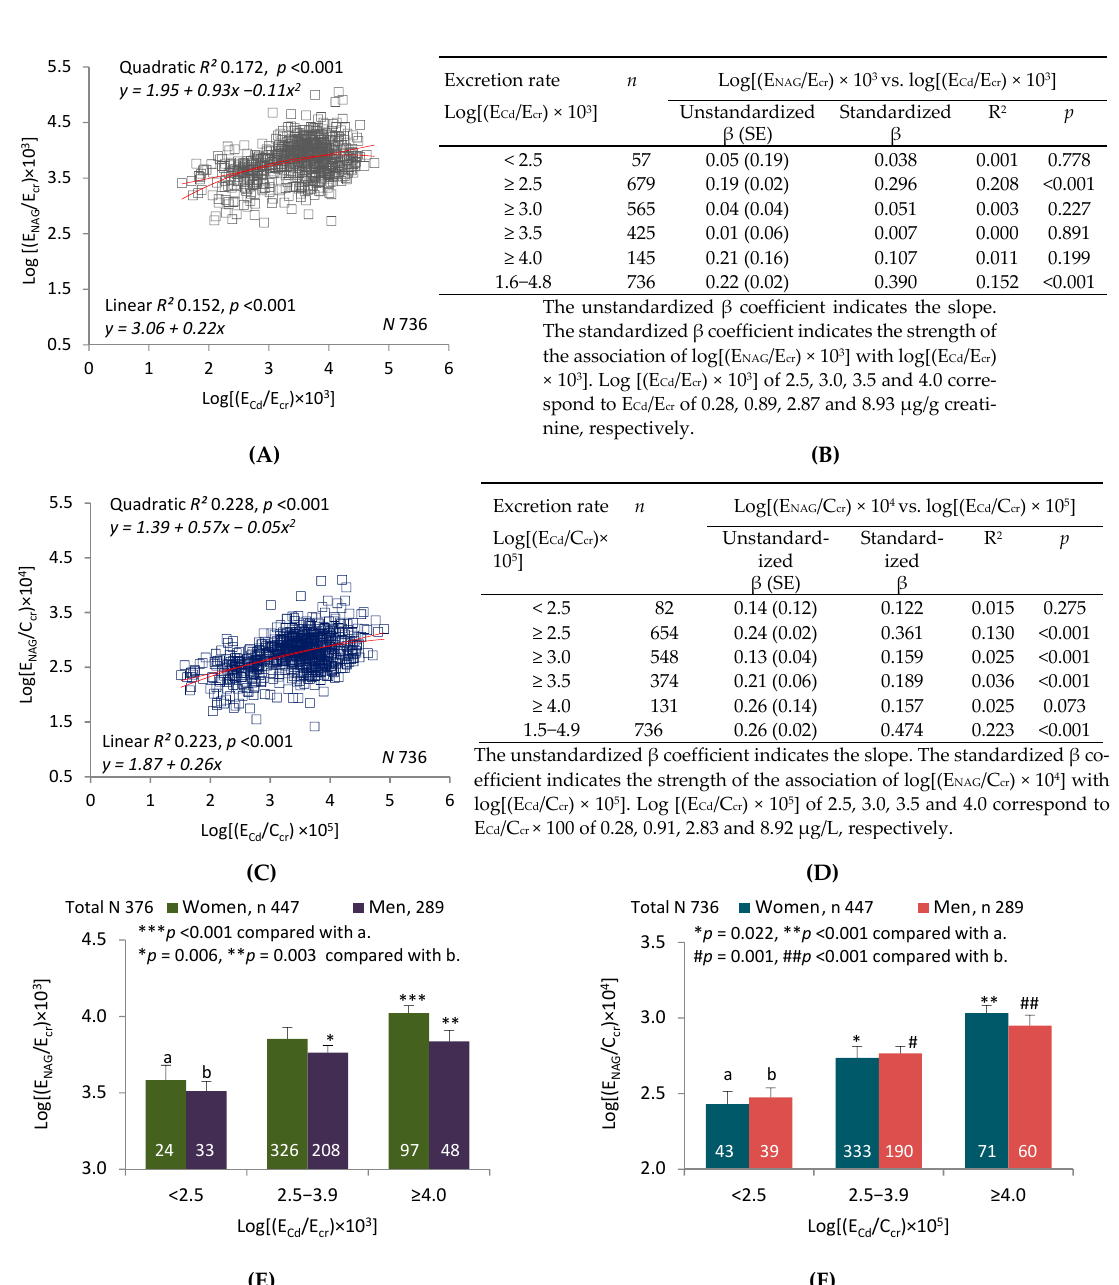
Figure 3. Direct relationships of parameters of NAG excretion to parameters of Cd excretion. Parameter abbreviations are summarized at the end of the text. Scatterplots in graphs ( A , C ) relate log[(E NAG /E cr ) × 10 3 ] to log[(E Cd /E cr ) × 10 3 ], and log[(E NAG /C cr ) × 10 4 ] to log[(E Cd /C cr ) × 10 5 ] in all subjects. Linear and quadratic equations, their respective coefficients of determination (R 2 ), and associated p -values are provided. In Table ( B ), linear relationships of log[(E NAG /E cr ) × 10 3 ] to log [(E Cd /E cr ) × 10 3 ] < 2.5, ≥ 2.5, ≥ 3.0, ≥ 3.5 and ≥ 4.0 are characterized with respective values of subject number ( n ), unstan- dardized and standardized β , R 2 , and p . In Table ( D ), linear relationships of log[(E NAG /C cr ) × 10 4 ] to log [(E Cd /C cr ) × 10 5 ] < 2.5, ≥ 2.5, ≥ 3.0, ≥ 3.5 and ≥ 4.0 are characterized with respective values of subject number ( n ), unstandardized and standardized β , R 2 , and p . In graphs ( E , F ), the bars represent mean log[(E NAG /E cr ) × 10 3 ] or mean log[(E NAG /C cr ) × 10 5 ] in women and men grouped by ranges of log[(E Cd /E cr ) × 10 3 ] or log[(E Cd /C cr ) × 10 5 ]. The subsets thus created are identical to those constituting Cd excretion levels in Table 3 and in Figure 1E,F. Numbers of subjects within each Cd excretion level and corresponding values of GM (SD) of E Cd /E cr and [(E Cd /C cr ) × 100] are as described in the legend for Figure 1. The letters a and b identify reference values in women and men, respectively, at the lowest rates of Cd excretion. Where appropriate, statistical comparisons are made within each gender between mean eGFR in bars a and b and mean eGFR at higher rates of Cd